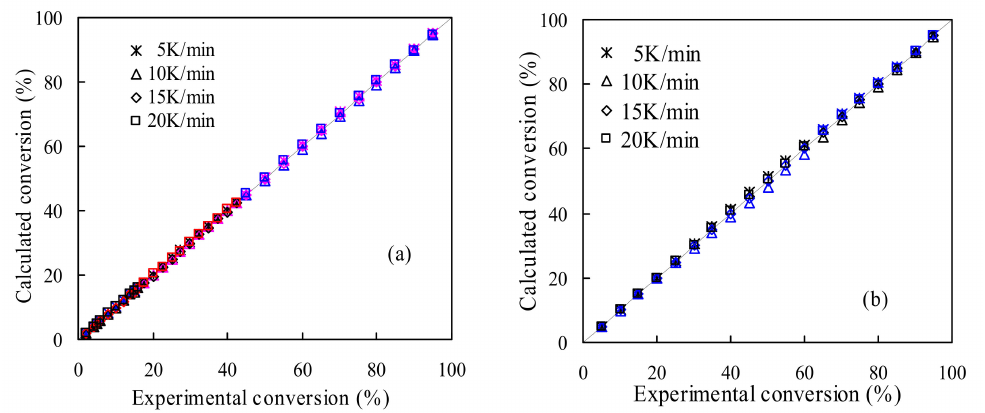
Figure 7. Simulated results for multi-stage pyrolysis processes of TSPU ( a ) and WPU ( b